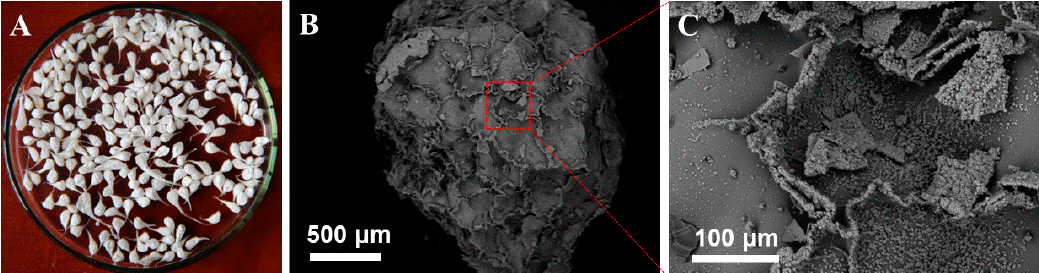
Figure 3. ( A ) Digital photo of Alg-EDTA; ( B ) SEM image of Alg-EDTA; ( C ) partial magnification of (B).